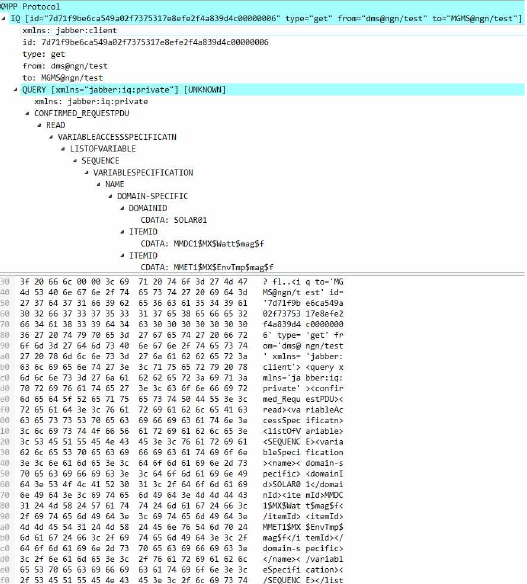
Figure 11. Packet captured from the DMS to the MGMS request message using the XMPP.